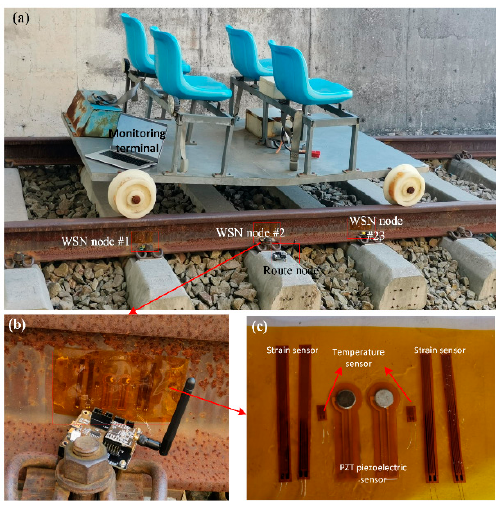
Figure 11. ( a ) Experimenta l setup for the online structural health monitoring of rail structures based on an MAS with SMFS; ( b ) optical image of WSN with SMFS; ( c ) optical image of